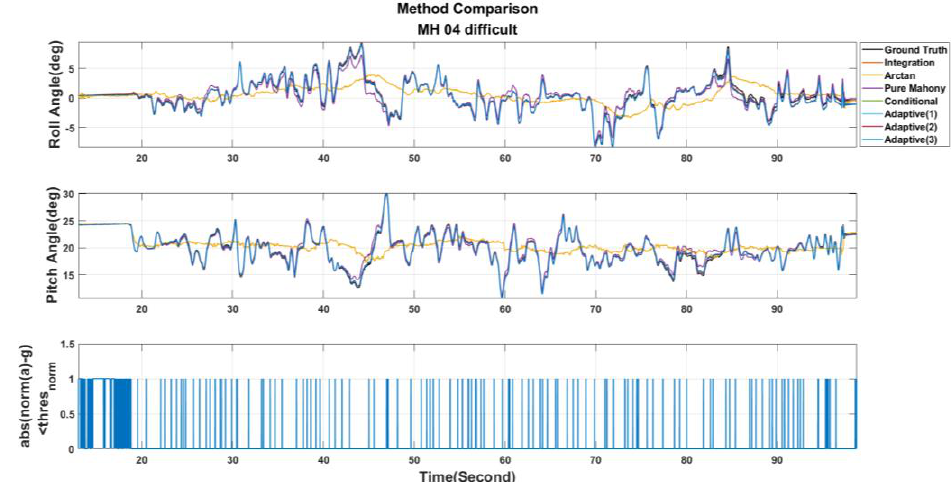
Figure 12. Roll and pitch angles were obtained from different adjustment strategies for the MH_03_me- dium series.